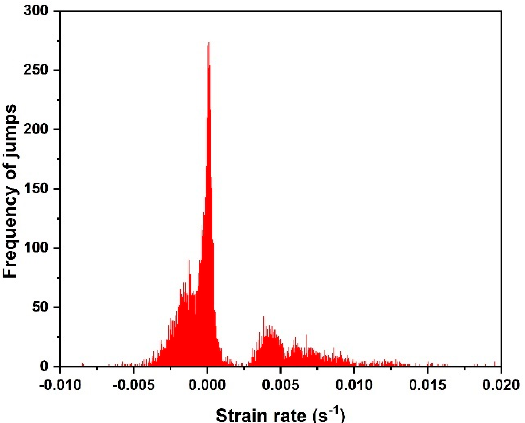
Figure 4. The number/frequency distribution of jumps within both crystalline and amorphous phases as a function of the strain rate.